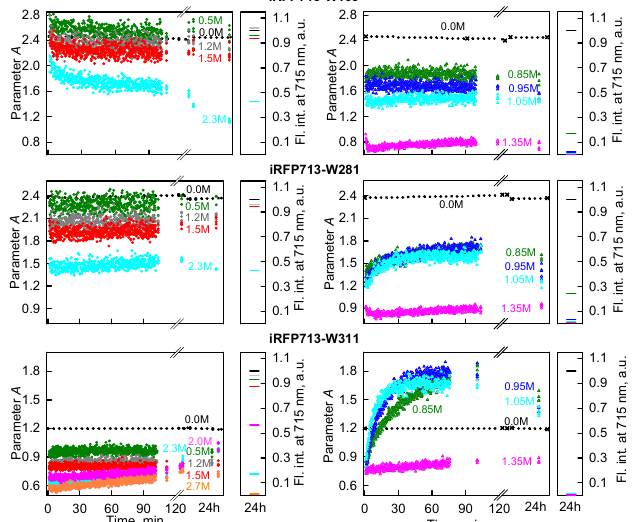
Figure 6. Kinetic traces of unfolding of mutant variants iRFP713-W109 , iRFP713-W281 , and iRFP713-W311 in the holoform induced by GdnHCl (left panel) and GTC (right panel). Changes in the parameter A = I 320 / I 365 at an excitation wavelength of 295 nm. The values of the chromophore fluorescence intensity at an excitation wavelength of 690 nm after 24 h after mixing the solutions of the mutant protein and denaturant are designated as lines on the right on the panels. Numerals at the curves specify applied denaturant concentration.